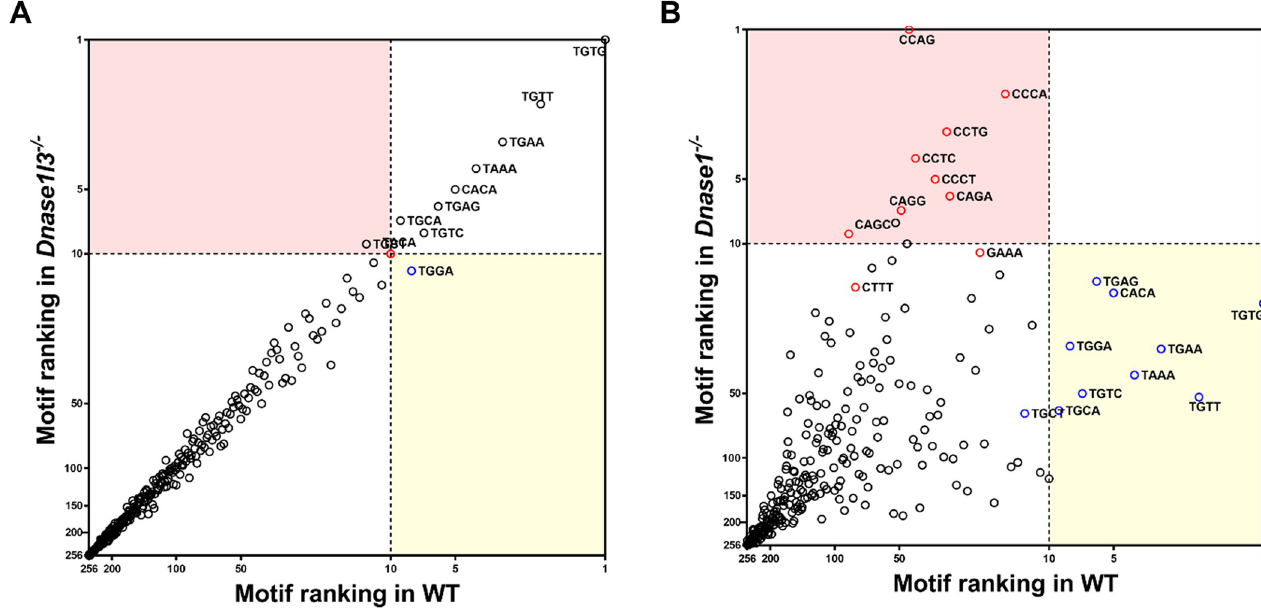
Fig 5. Relationship of motif rankings in ucfDNA between WT and nuclease deficient mice. Correlations of the end motif rankings between WT and Dnase1l3 -/- groups (A), and WT and Dnase1 -/- groups (B). Each circle represents a 4-mer motif. Top 10 motifs in WT group were indicated with blue circles, while those derived from Dnase1l3 -/- , and Dnase1 -/- groups were indicated by red